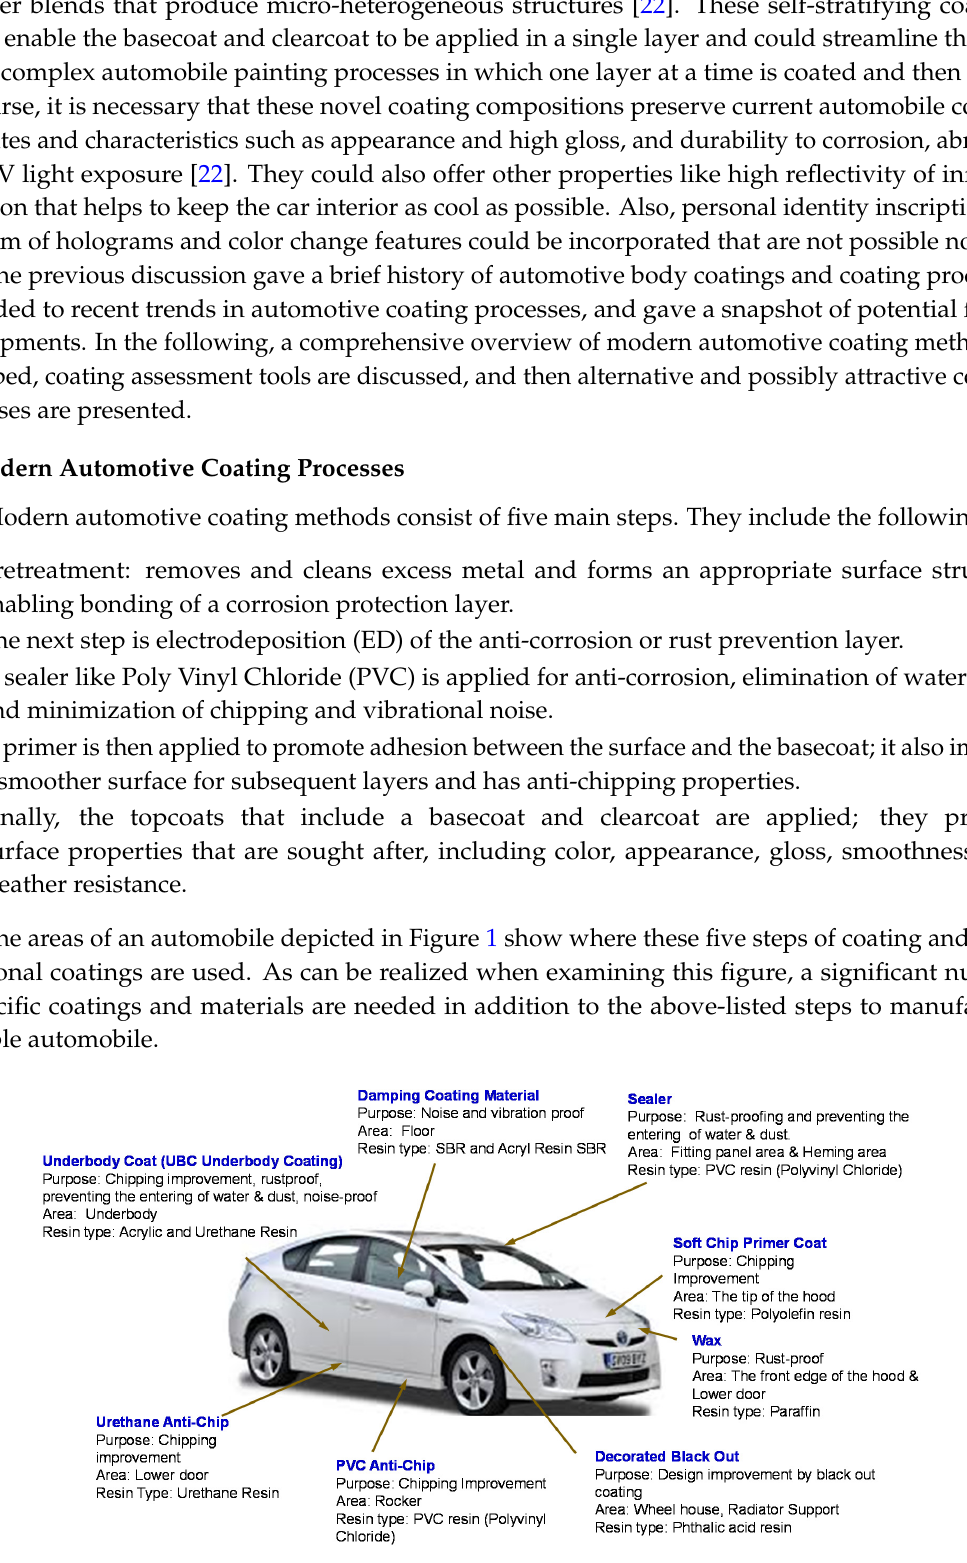
Figure 1. Summary of coating tasks for specific areas.